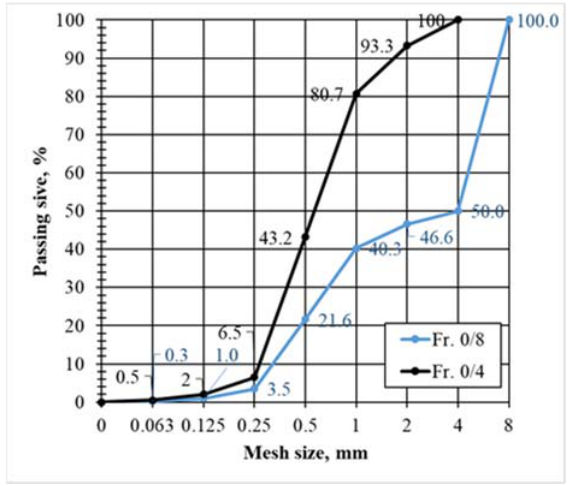
Figure 2. The grain size distribution of lightweight aggregate blends for lightweight aggregate shotcretes. The black curve is Mix 1, and the blue curve is Mix 2 and Mix 3. Table 4. The composition lightweight aggregate shotcrete for a cubic meter (kg/m 3